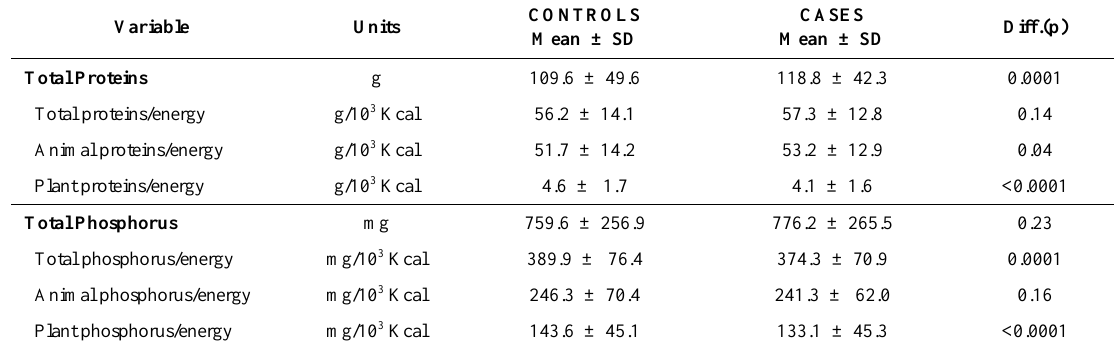
Table 3. Mean daily values ± standard deviation of the acid load scores and their components. Stratification of items according to their animal/plant original source. Comparison between cases and